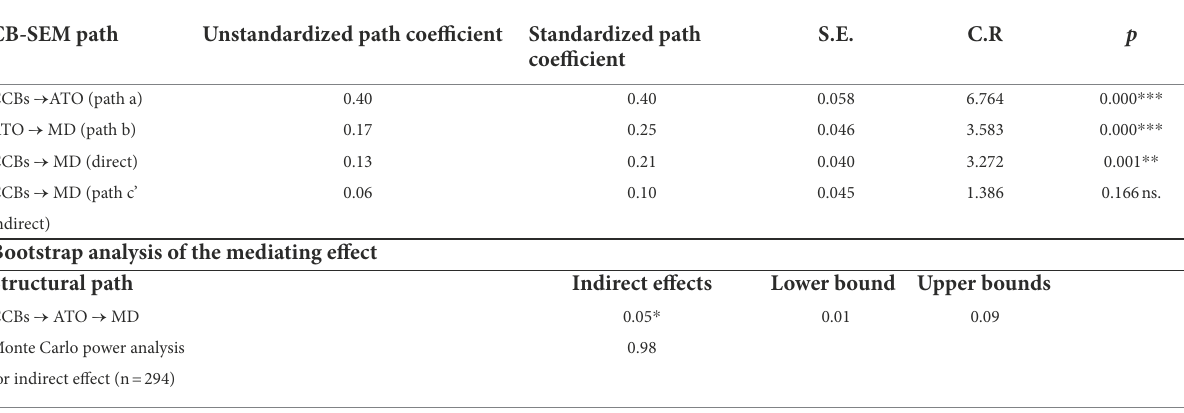
TABLE 3 CB-SEM path coefficients and Bootstrap analysis of the mediating effect.